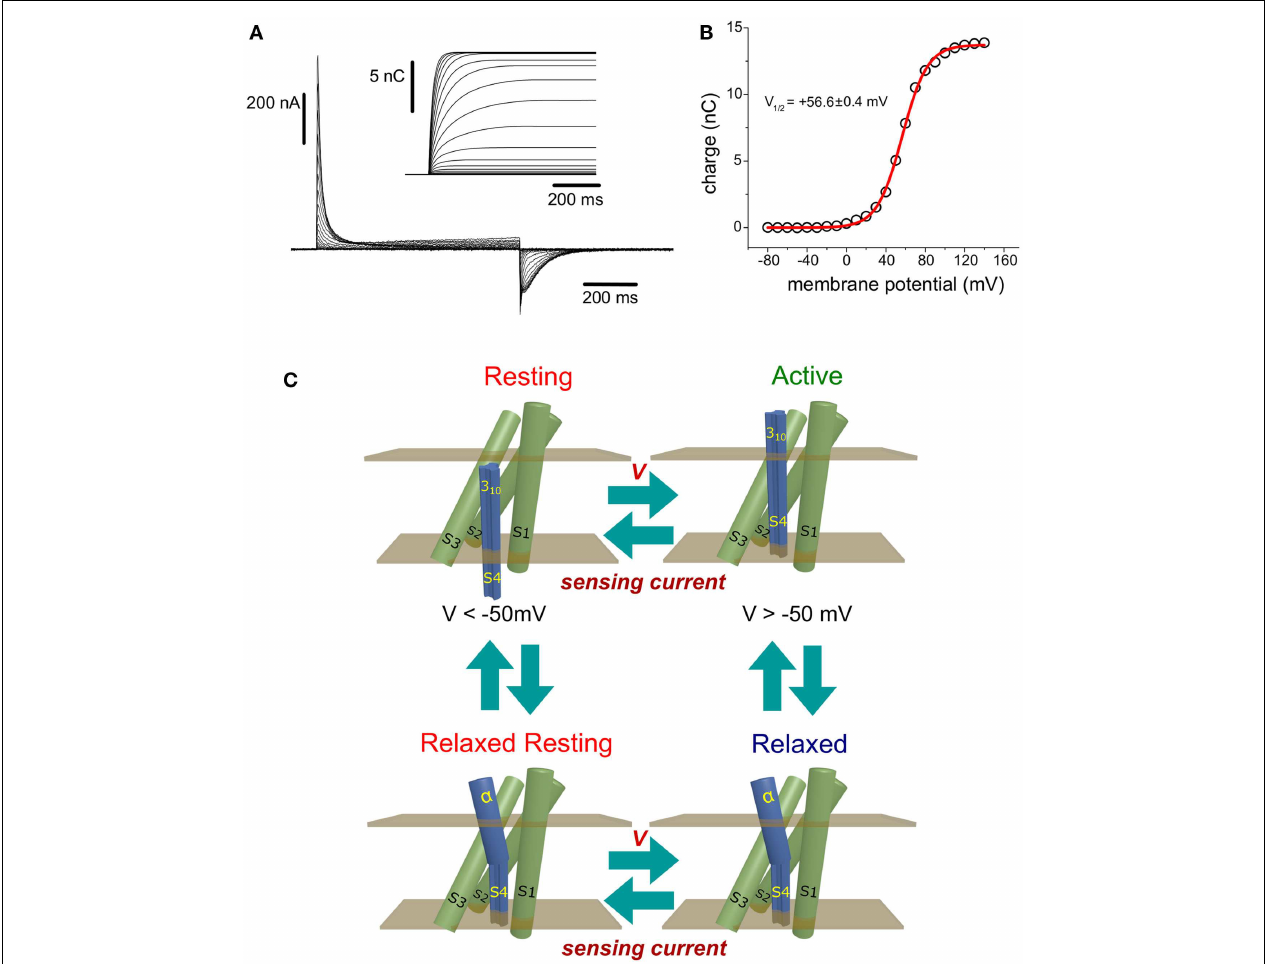
FIGURE 1 | (A) Ci-VSP-C363S sensing currents recorded from Xenopus oocytes using the cut-open voltage clamp technique (Taglialatela et al., 1992).The holding potential (HP) was set to − 60mV, and ON-sensing currents were evoked by 800ms-test pulses ranged − 80 to + 140mV. OFF-sensing currents were recorded at − 60mV. Numerical integration of the ON-sensing currents (inset) was performed using a package developed by the author using the programming language Java. (B) Maximum (steady state) net charges are calculated by integration were plotted against